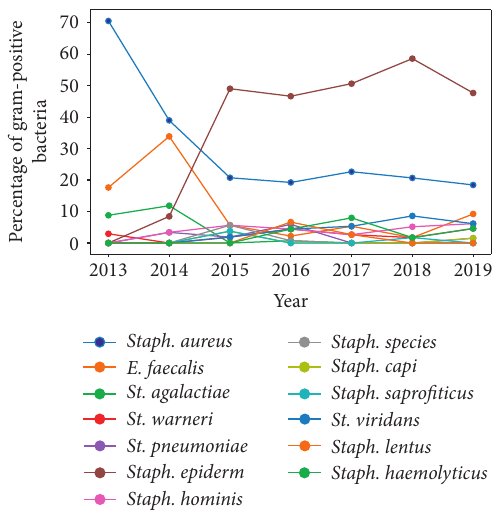
Figure 10: Percentage of gram positive bacteria.